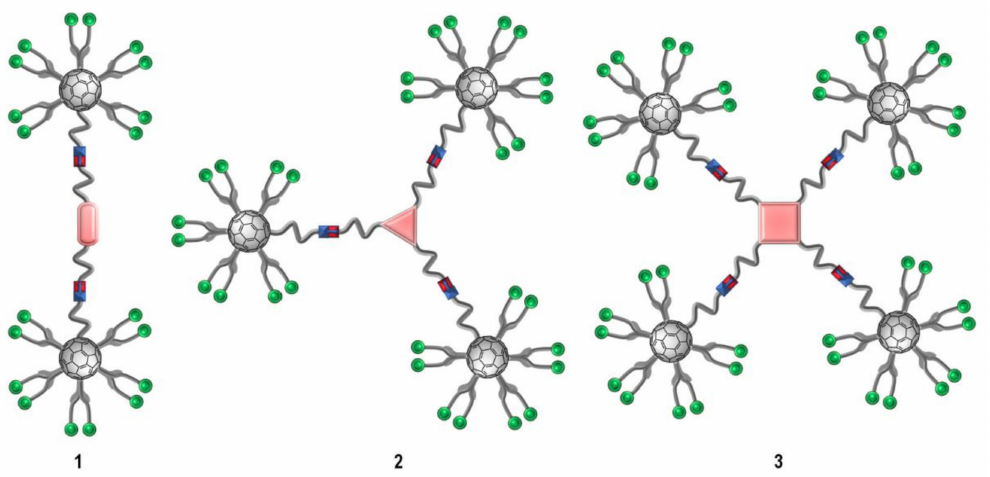
Figure 1. General structures of topologically different oligomers containing two, three, or four glycofullerenes ( 1 – 3